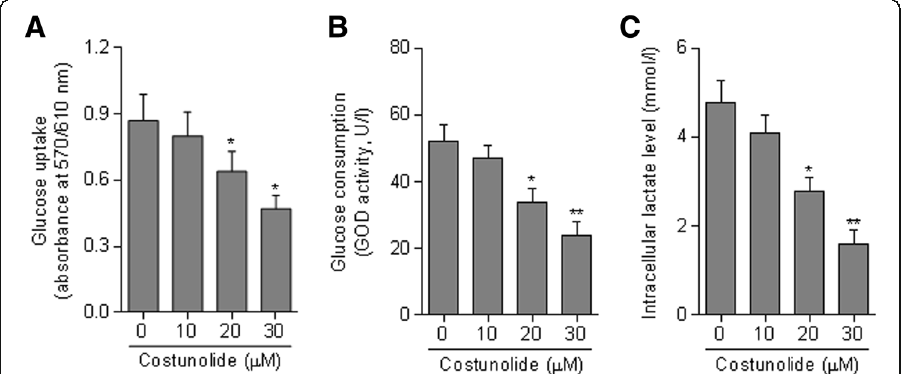
Fig. 2 Costunolide blocks aerobic glycolysis in HSCs. Primary rat HSCs at passages 3 through 5 were treated with costunolide at the indicated concentrations for 24 h. a – Measurement of glucose uptake using absorbance at 570/610 nm. b – Measurement of glucose consumption represented by GOD activity. c –